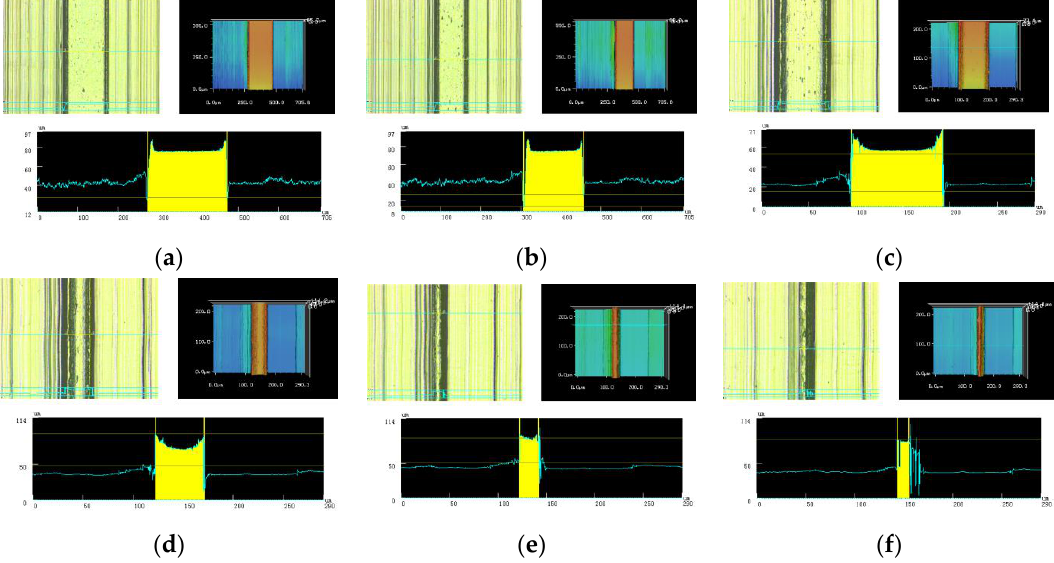
Figure 7. SEM photographs of microtextures at different widths: ( a ) 200 μm , ( b ) 150 μm, ( c ) 100 μm, ( d ) 50 μm, ( e ) 20 μm, ( f ) 10 μm.